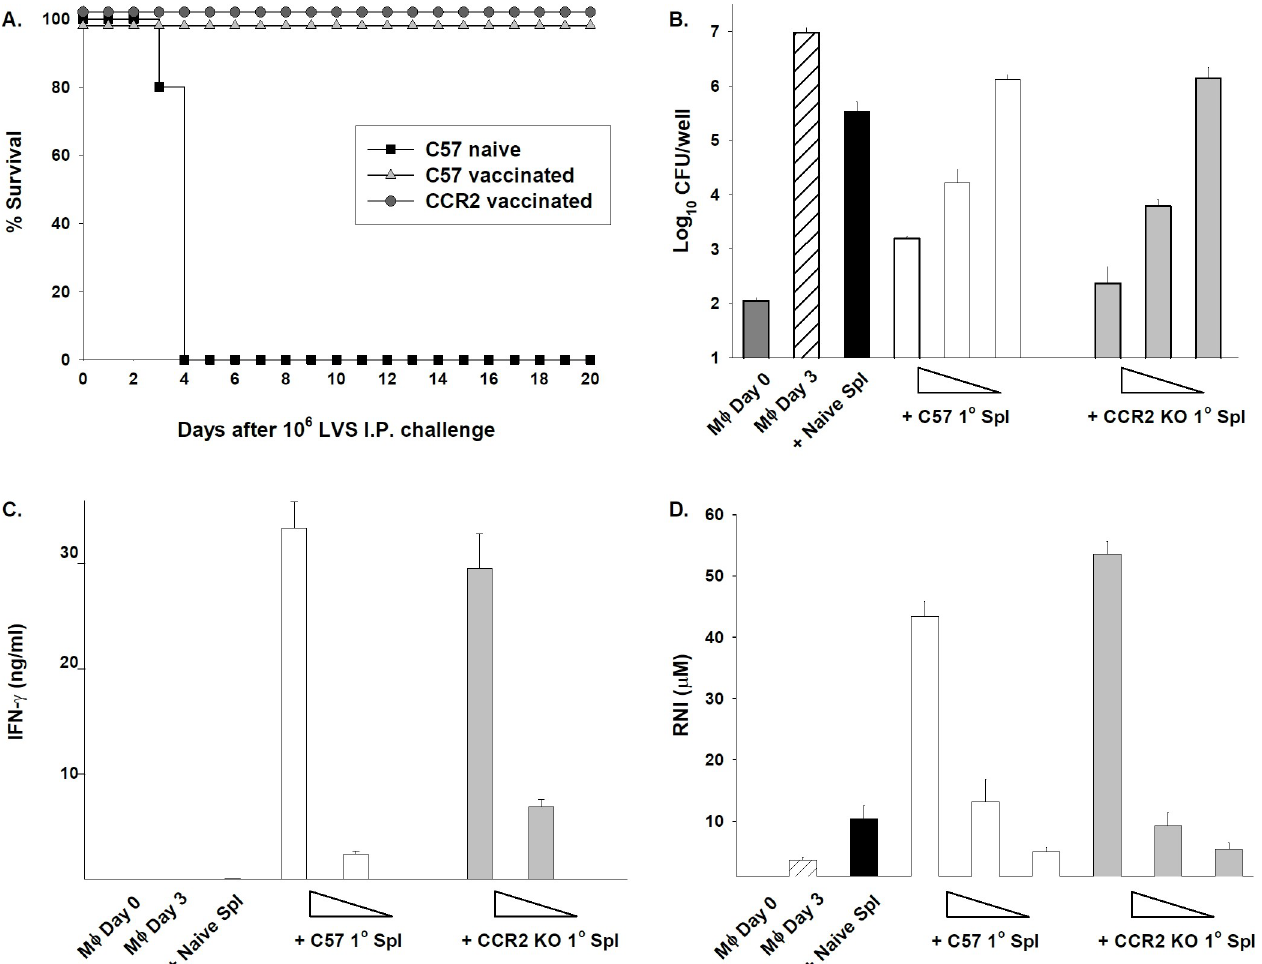
Fig 4. LVS-immune CCR2 KO mice are similar to C57BL/6J mice in surviving maximal secondary lethal LVS challenge and generating immune T cells that control intramacrophage LVS growth. A) Groups of five C57BL/6J or CCR2 KO mice were treated with PBS (na ï ve) or vaccinated by ID infection with 5 x 10 0 CFU LVS. After one month, all mice were challenged with 10 6 LVS IP. Actual doses were confirmed by retrospective plate count and were within 15% of the target. Survival was monitored for at least 30 days, but no further deaths occurred after day 6. Results are shown from one representative experiment of three independent experiments of similar design and outcome that used a total of 15 C57BL/6J mice and 14 CCR2 KO mice. Overlapping lines are offset for clarity. The survival of LVS-challenged na ï ve C57BL/6J mice was significantly different from that of LVS-challenged primed C57BL/6J or primed CCR2 KO mice, with p = 0.0035 for both pairwise comparisons per log-rank (Mantel-Cox) tests. B) Splenocytes from the same LVS-immune C57BL/6J and CCR2 KO mice were isolated and pooled (designated as “1˚ cells” on the graphs); splenocytes were also obtained from naive mice. Bone marrow-derived macrophages (M ϕ ) from C57BL/6J mice were infected with LVS, and then splenocyte populations were added to triplicate wells of infected macrophages. For na ï ve and the first series of LVS-immune splenocytes, 5 x 10 6 lymphocytes were added per well to triplicate wells per condition. For titration of lymphocytes, 2.5 x 10 6 or 1 x 10 6 immune splenocytes were added, depicted as to represent decreasing numbers of added lymphocytes. Intracellular bacterial burdens represented as CFU/ well were assessed immediately after infection at 0 hours (designated as M ϕ Day 0 on the graphs) and at 72 hours (M ϕ Day 3) after the initiation of co-cultures and compared to numbers of recovered CFU/well from infected macrophages co-cultured with added lymphocytes, as indicated. C) Supernatants were harvested from the co-cultures shown in B and assayed for amounts of IFN- γ by ELISA. Results shown are the mean of triplicate wells. C) Supernatants were harvested from the co-cultures shown in B and assayed for RNI levels using the Griess reagent. Results shown are the mean of triplicate wells. Results shown in B, C, and D are from one representative experiment of seven of similar design and outcome. https://doi.org/10.1371/journal.pone.0249142.g004 LD of LVS in C57BL/6J mice is typically about 10 3 –5 x 10 3 CFU, and therefore those data 50 imply that the susceptibility of CCR2 KO mice to IN LVS infection is not different from wild type mice. Another study compared responses of C57BL/6J and CCR2 KO mice to an IV dose of 2 x 10 4 LVS, but most studies were performed using mice infected for only 24 hours [18],